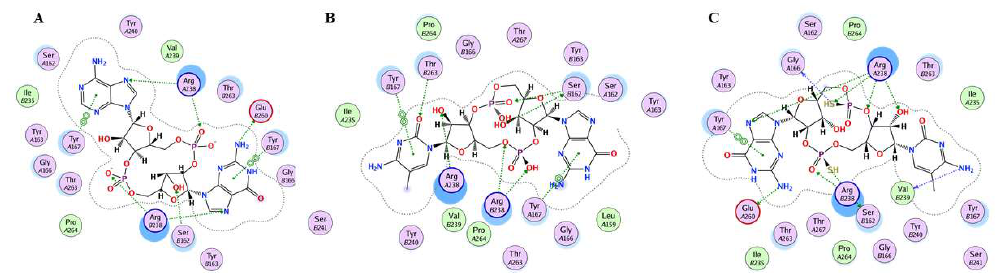
Figure 5. ( A ) The binding mode of cGAMP and hSTING (Protein Data Bank (PDB) code: 4LOH). ( B )The 2D-binding mode of 8c and hSTING by docking calculation. ( C ) The 2D-binding mode of 8d and hSTING by docking calculation.